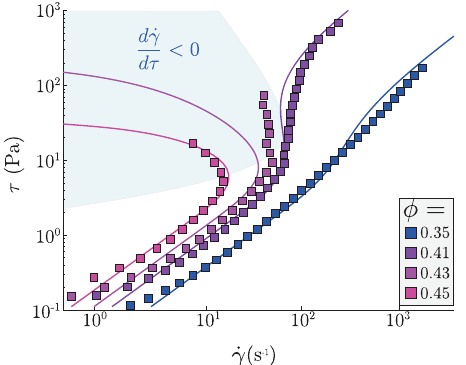
Fig. 3 Rheograms of the aqueous cornstarch suspension. Shear-stress τ versus shear rate _ γ for various volume fractions ϕ . Solid lines: fi t by Wyart & Cates rheological laws setting the jamming volume fraction for frictionless and frictional particles to ϕ 0 = 0.52 ± 0.005 and ϕ 1 = 0.43 ± 0.005, respectively, the short-range repulsive stress scale above which the frictional transition occurs to τ * = 12 ± 2 Pa and the prefactor to η s = 0.91 ± 0.01 mPa s. The rheograms are negatively sloped (d _ γ = d τ < 0) in the region highlighted in